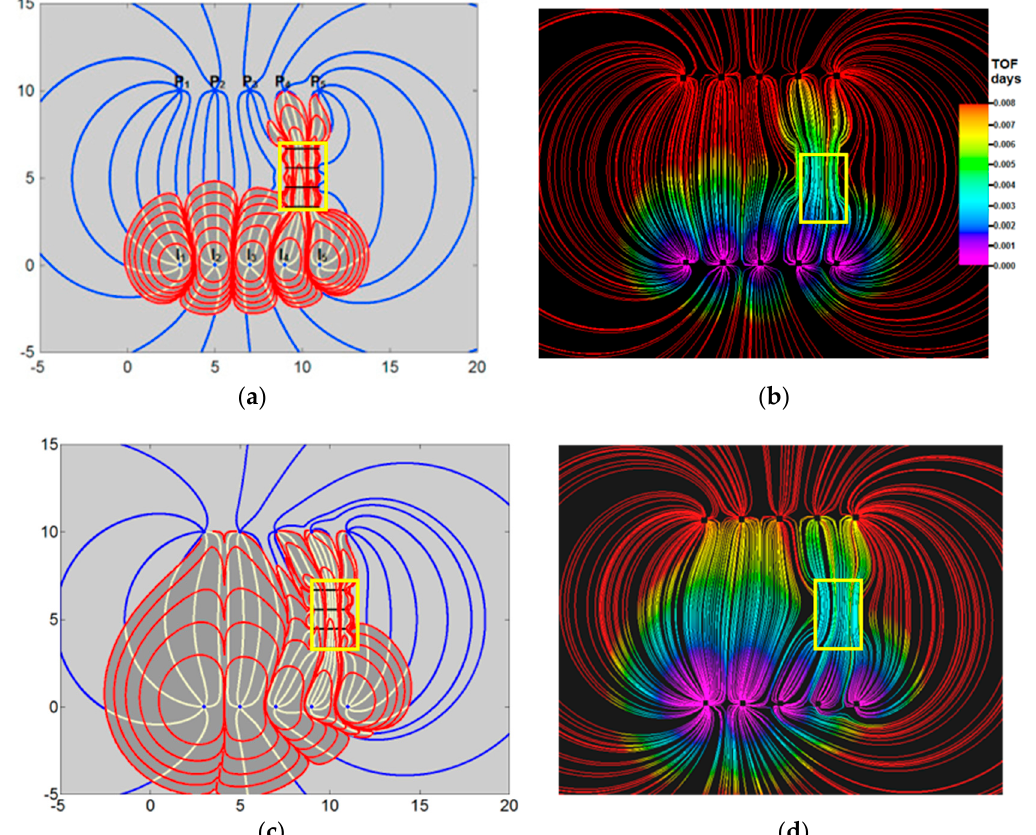
Figure 6. Grid-less CAM simulation (left images) before ( a ) and after ( c ) injector rate optimization of the five injector wells (bottom array I1-I5) in a direct line drive toward five producer wells (top array P1-P5). Grid-based Eclipse simulations ( b , d ) confirm the accuracy of CAM flow simulations and matching time of flight contours. Reproduced with permission from [26]. The high permeability zone in the rectangular space (yellow box) is 10 times more permeable than the ambient reservoir space (1000 mD as compared to ambient 100 mD).